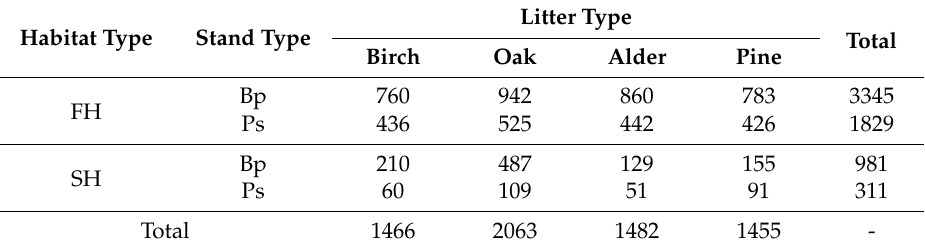
Table A2. Total abundance of mite individuals in four types of litter in Betula pendula (Bp) and Pinus sylvestris (Ps) stands growing in forest habitat (FH) and spoil heap (SH).